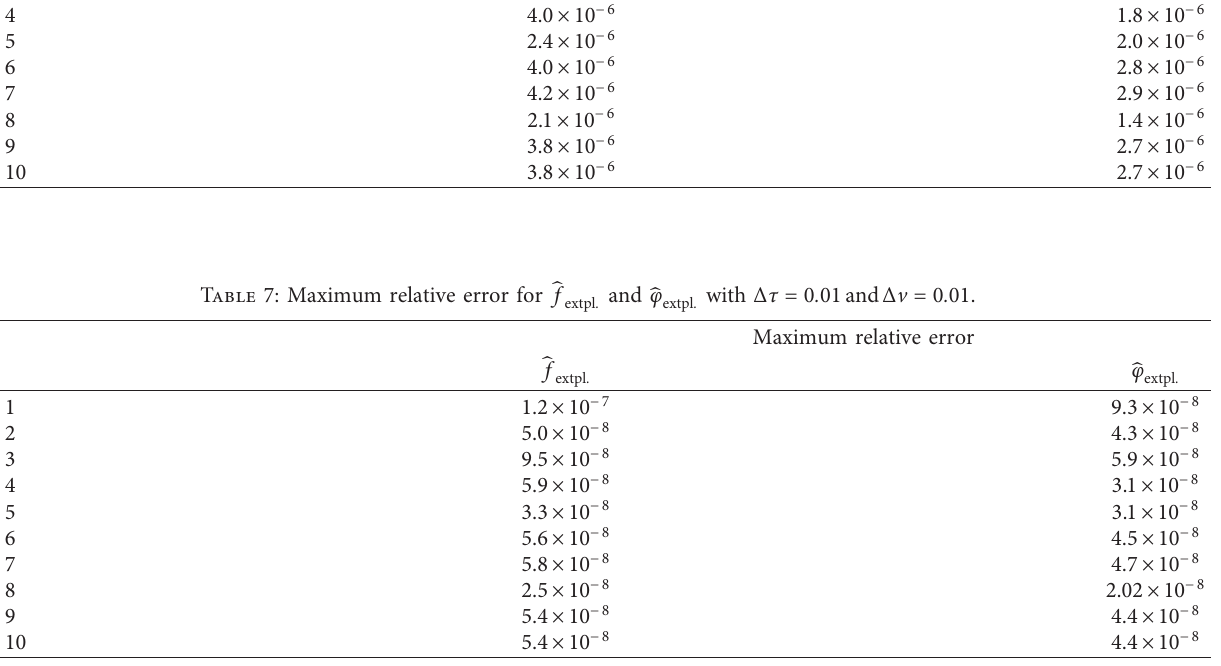
Table 8: Maximum relative error for 􏽢 f